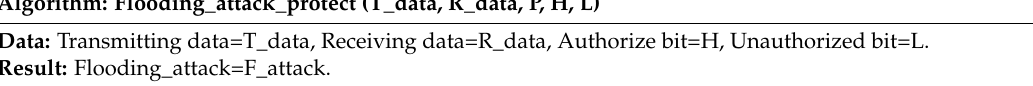
Table 4. Pseudocodes used to prevent Flooding attack in the proposed SIF using Zigbee